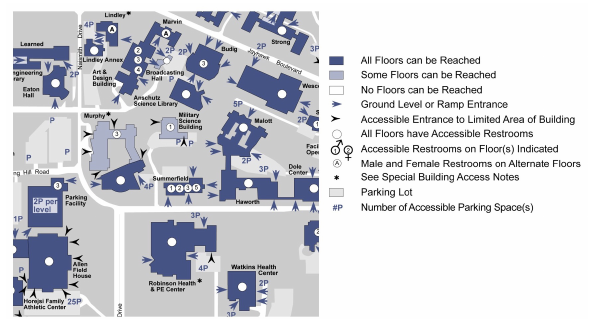
Figure 3. University of Kansas (USA) campus accessibility map.